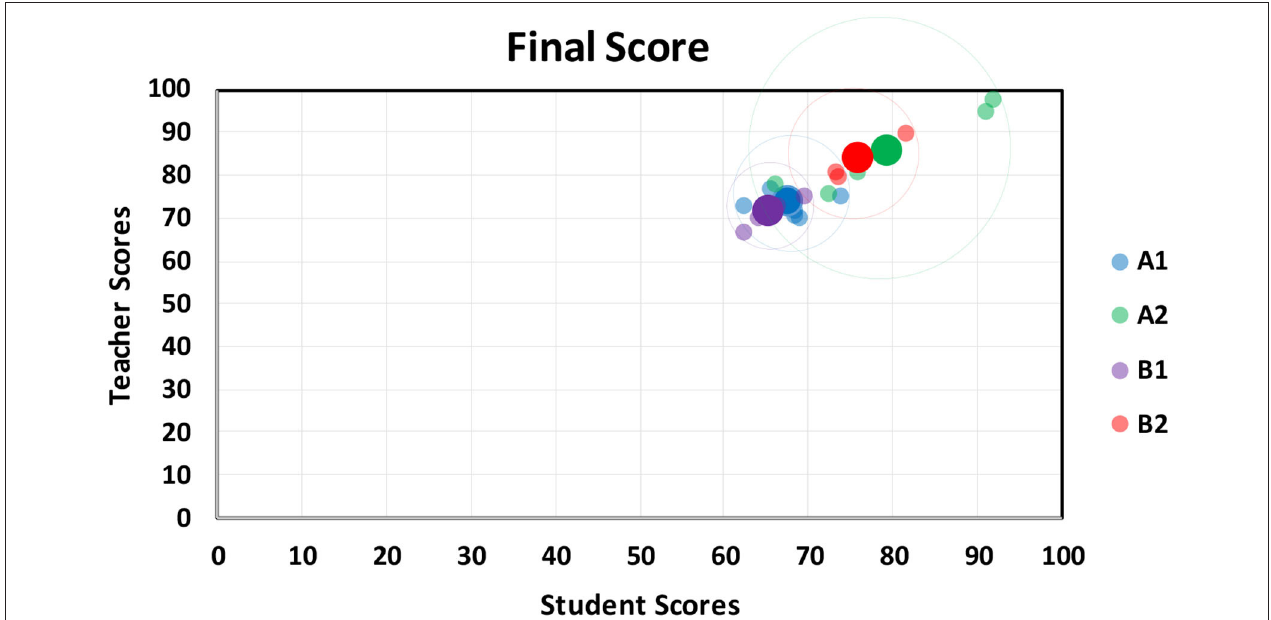
FIGURE 4 | Final score approach: classes A1, A2, B1, and